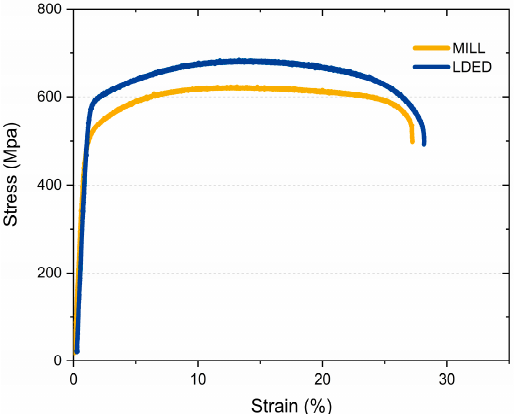
Figure 8. Representative stress strain curves of both MILL and LDED materials.